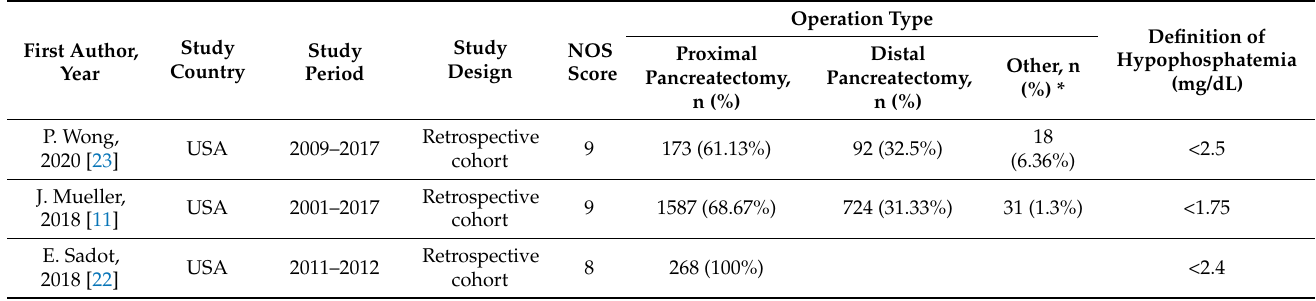
Table 1. Description of the studies included in the systematic